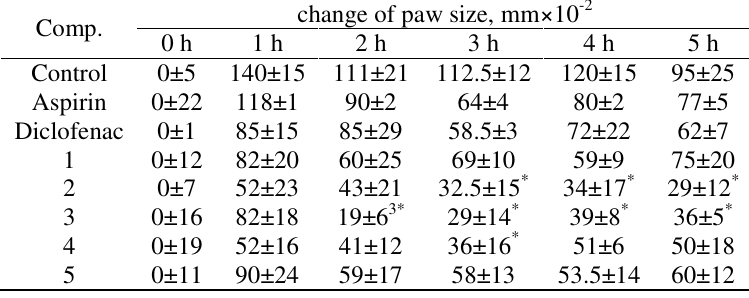
Table 8 . Carrageenan induced inflammation tests of histidine derivatives.